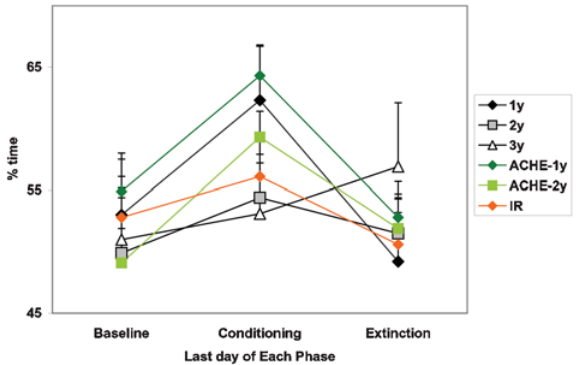
Figure 3. Spatial entrainment in zebrafish groups. Percent time spent in the US-associated side of the tank during food anticipation, i.e., 30 min interval prior to CS presentation, at the end of Baseline, Conditioning and Extinction phases. Young fish (1 y) – diamond, middle-aged (2 y) fish – square, old fish (3 y) – triangle. Wildtype – black; ACHE mutants – green; IR zebrafish – orange.